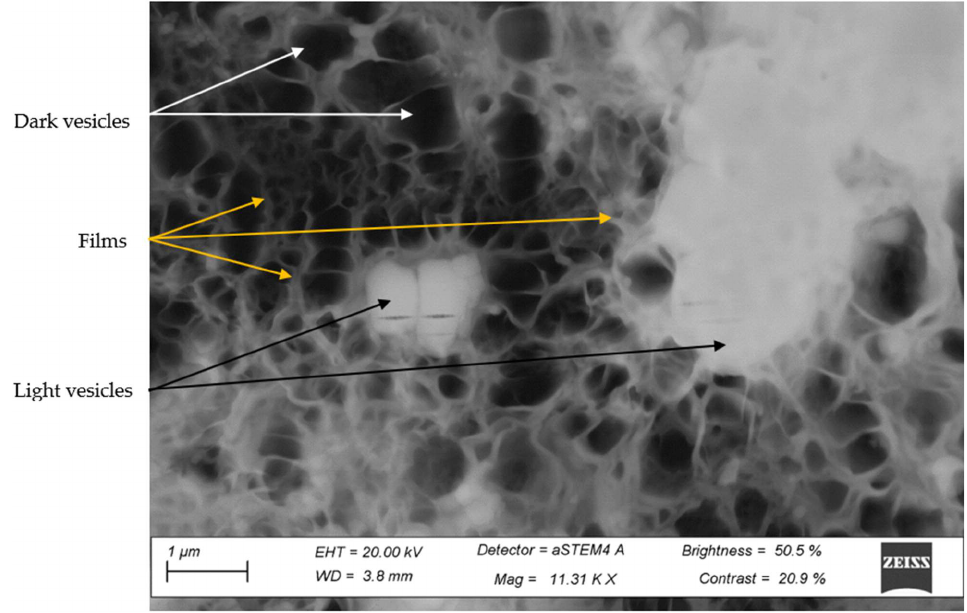
Figure 11. STEM image with HAADF mapping of third phase. Vesicles: bright and dark amorphous areas with distinct boundaries indicated by black and white arrows, respectively; films: filamentous grey regions surrounding vesicles indicated by yellow arrows.